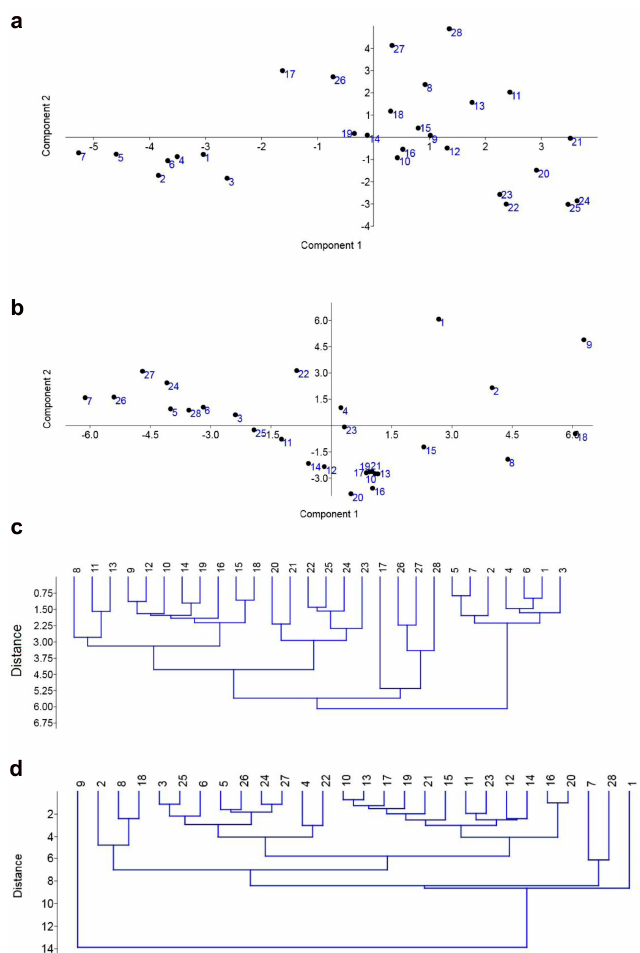
Figure 7. PCA two-dimensional score plot of FTIR spectra ( a ) and Raman spectra ( b ) for principle components (PA) 1 and 2 based on lipid-carbohydrate ratio and α / β structure ratio. HCA analysis based on FTIR spectra ranging from 500 to 4000 cm − 1 ( c ) and Raman spectra ranging from 500 to 3000 cm − 1 ( d ). Representative dendrograms are shown. C. albicans group (1, 2, and 4–19), C. tropicalis group (20, 21), C. glabrata group (3 and 22–25), 302 haploid reference strain (26), SC5314 diploid strain (27), and T15 tetraploid strain (28).